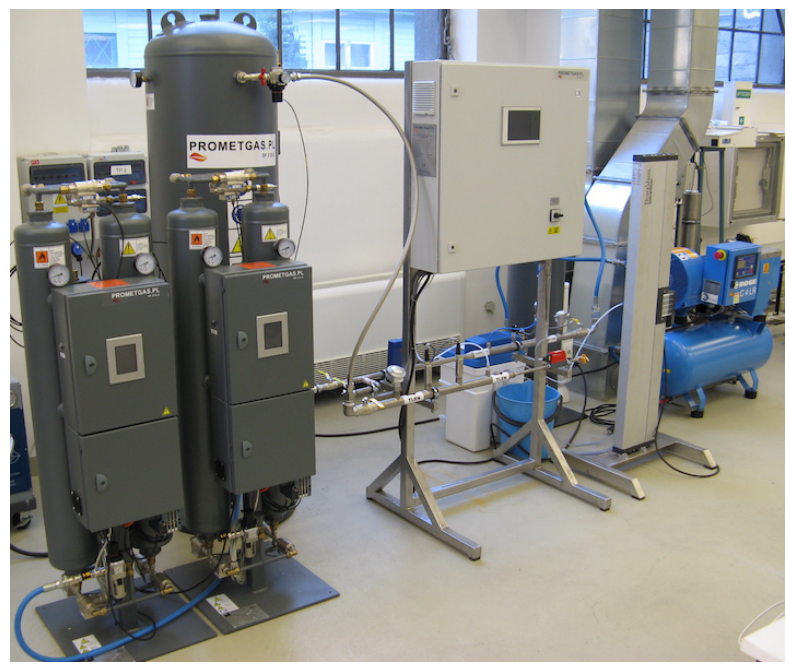
Figure 4. The test stand